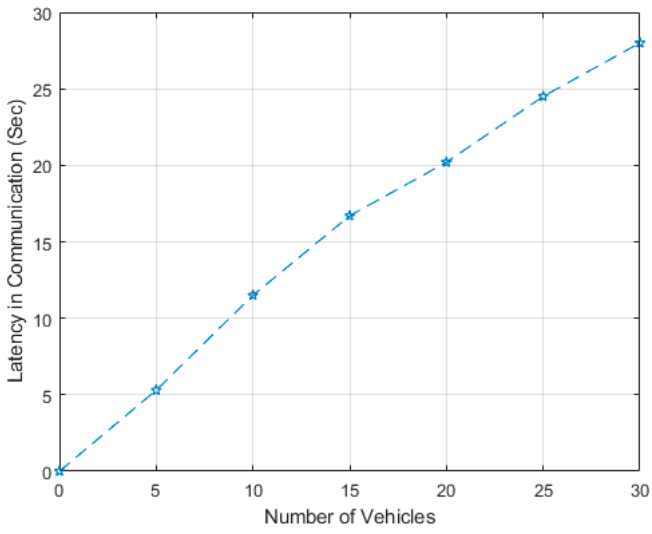
Figure 11. Latency in